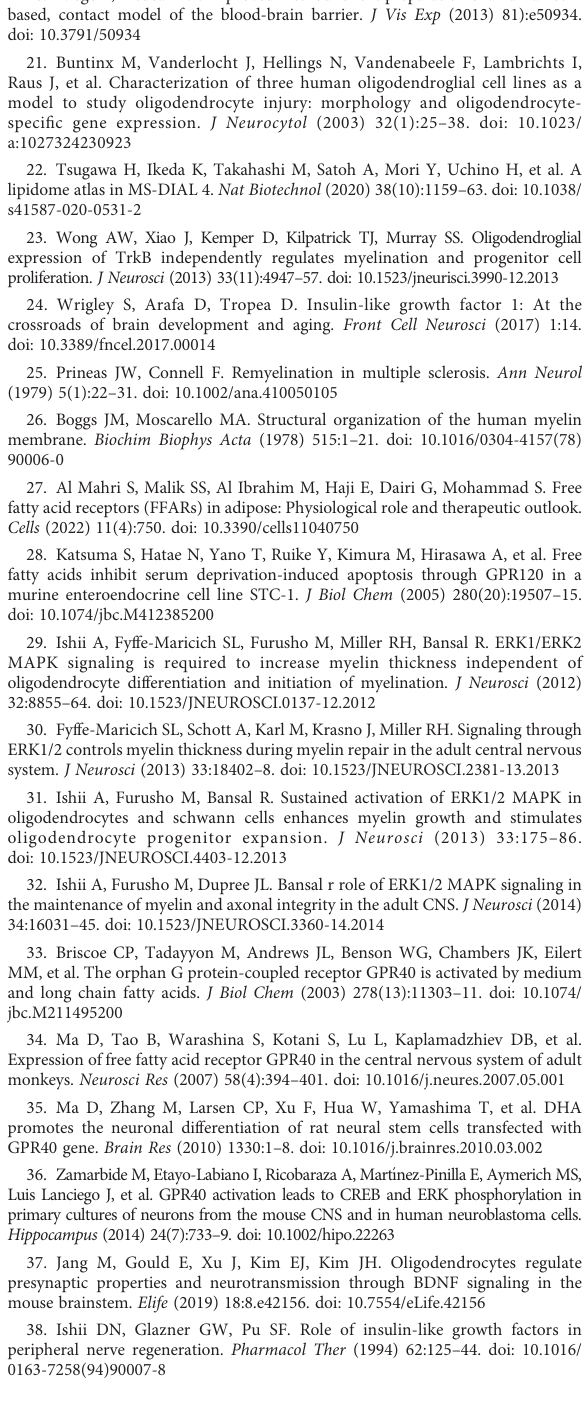
SUPPLEMENTARY TABLE 1 The effect of FOM and borage oil (BO) on the lipid composition in hOPCs performed by gas chromatography-mass spectrometry. The blue color indicates the main lipids involved in NA synthesis as substrates, yellow as